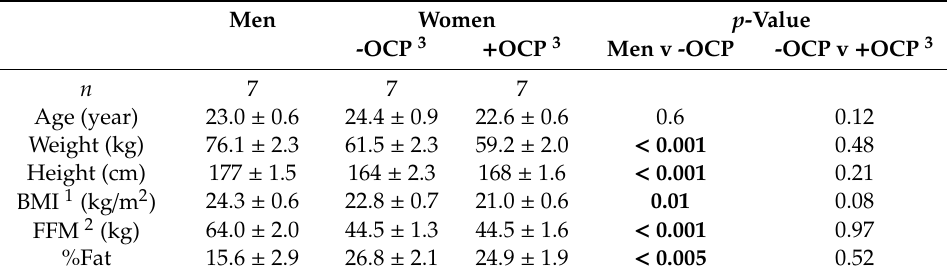
Table 2. Participant characteristics (mean ± SEM).